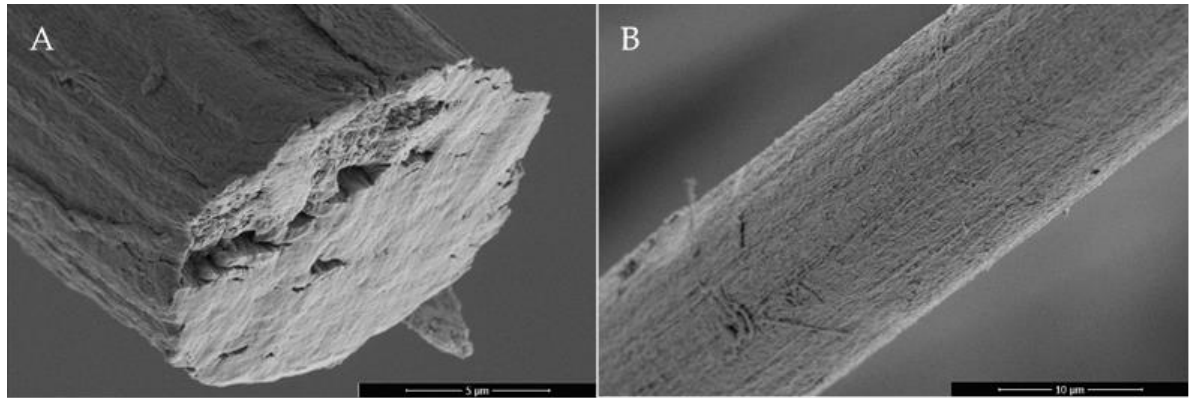
Figure 2. SEM images of the cross-section ( A ) and the surface ( B ) of the control fibers without stretching and NC addition.